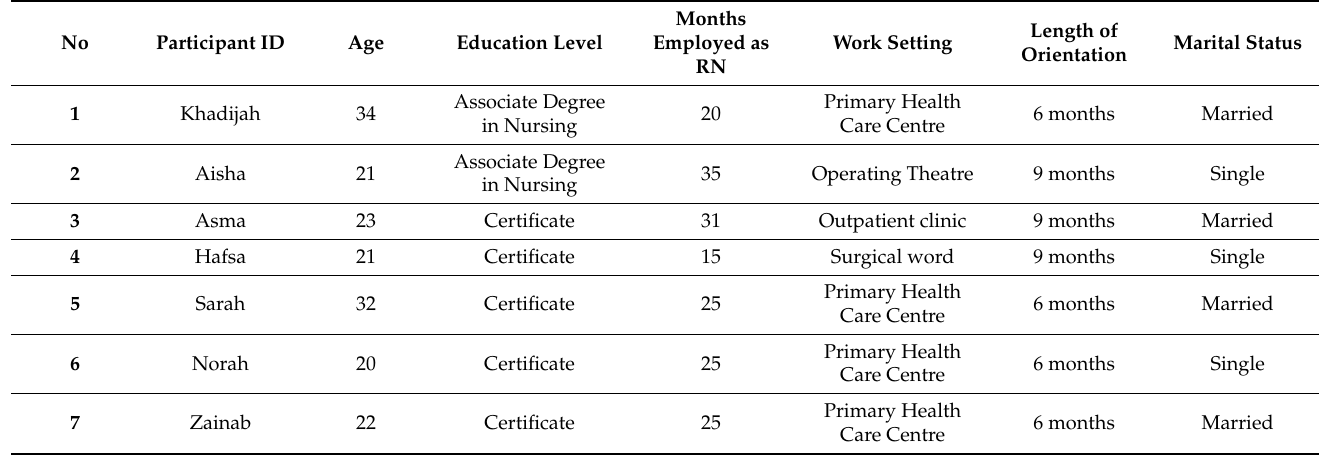
Table 1. Demographic and employment characteristics of